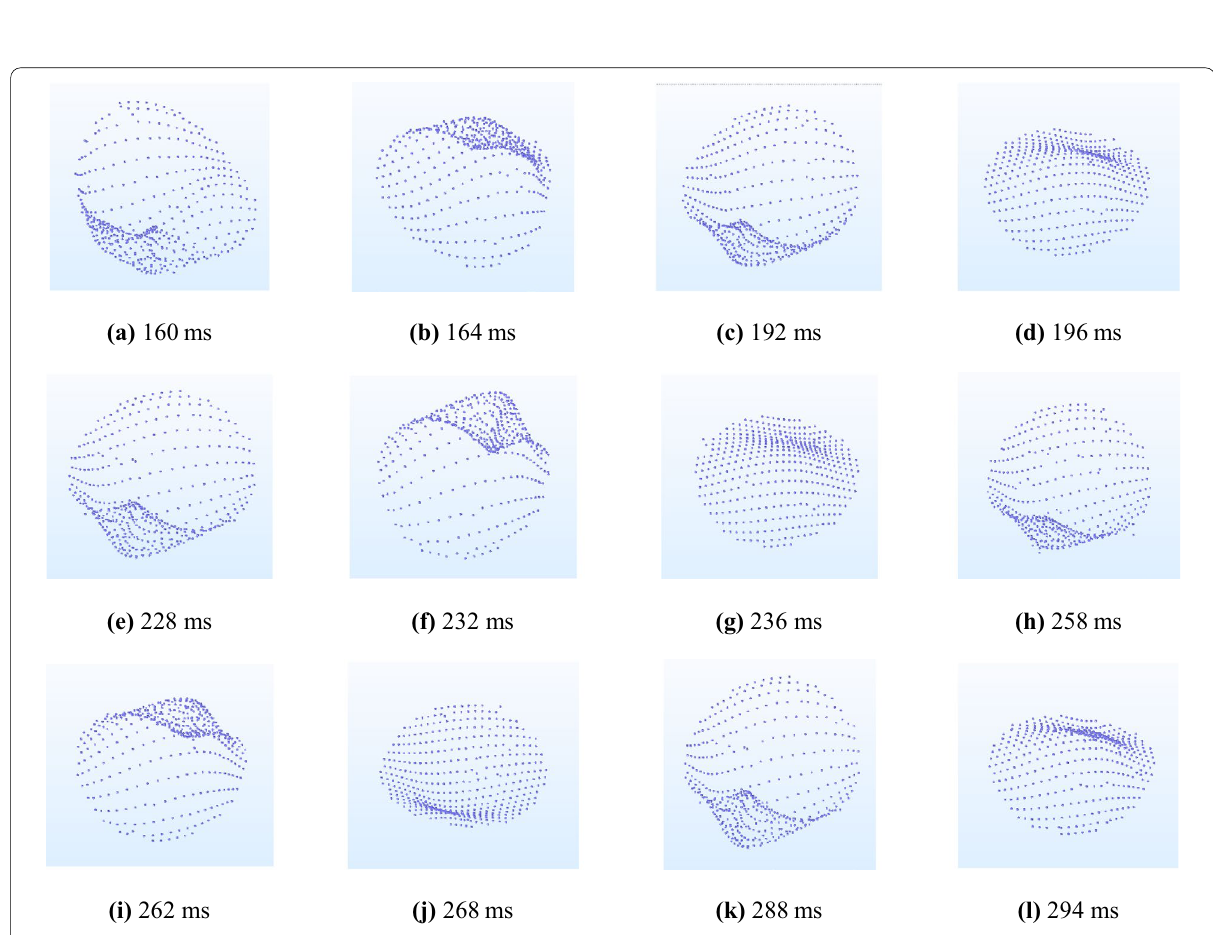
Figure 8 Dot matrix image of (1, 1) mode